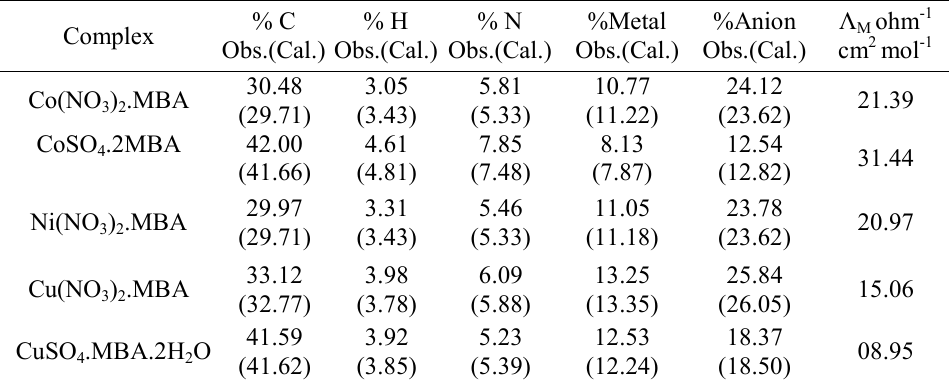
Table 1. Analytical and Conductance Data for Co II , Ni II , and Cu II complexes of MBA. Complex